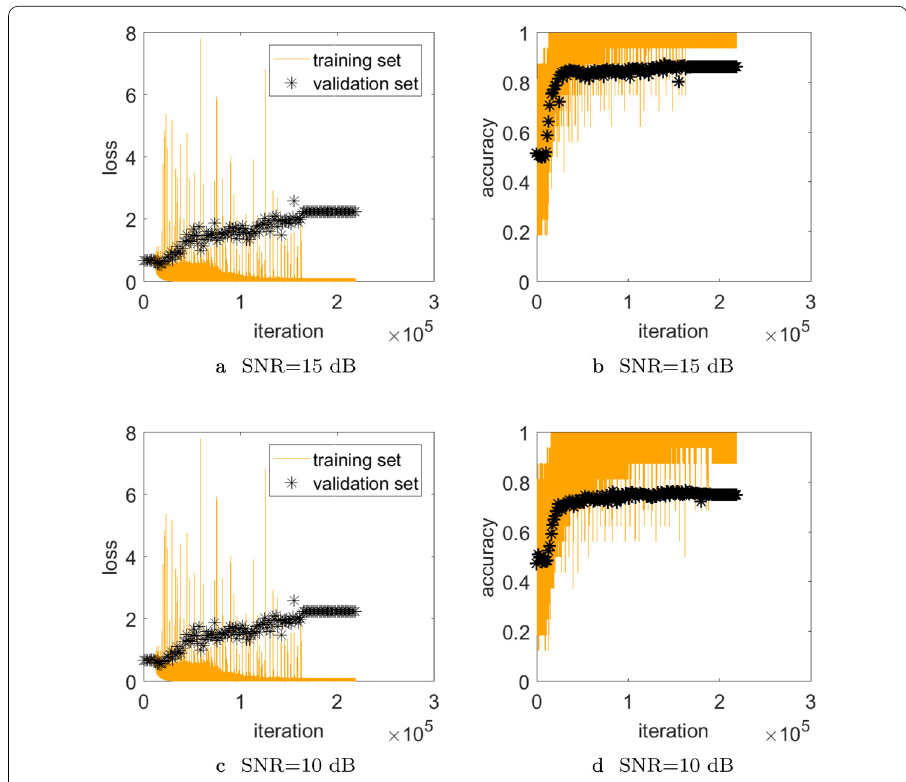
Fig. 14 Damage detection, case 1. Training and validation of the two branches convolutional architecture: evolution of the loss J d ( Y , p ) on D d and D d (left column), and of G d accuracy A d (right column) on D d train val and on D d , both for the SNR = 15 dB case (top row) and for the SNR = 10 dB case (bottom val